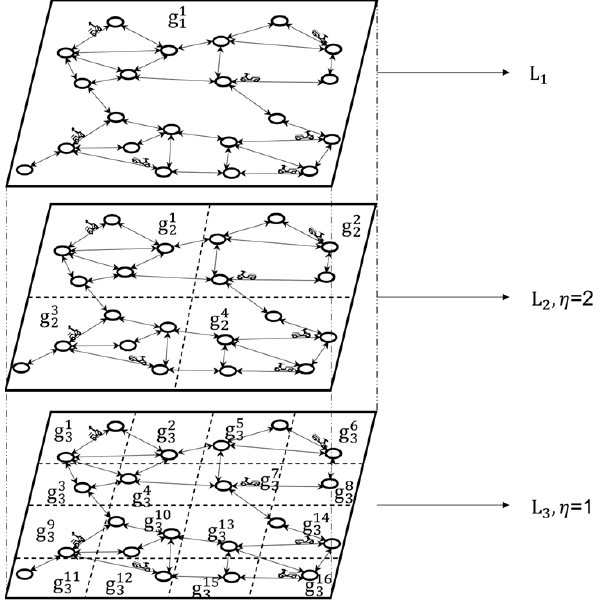
Figure 3. Diagram of road network division.